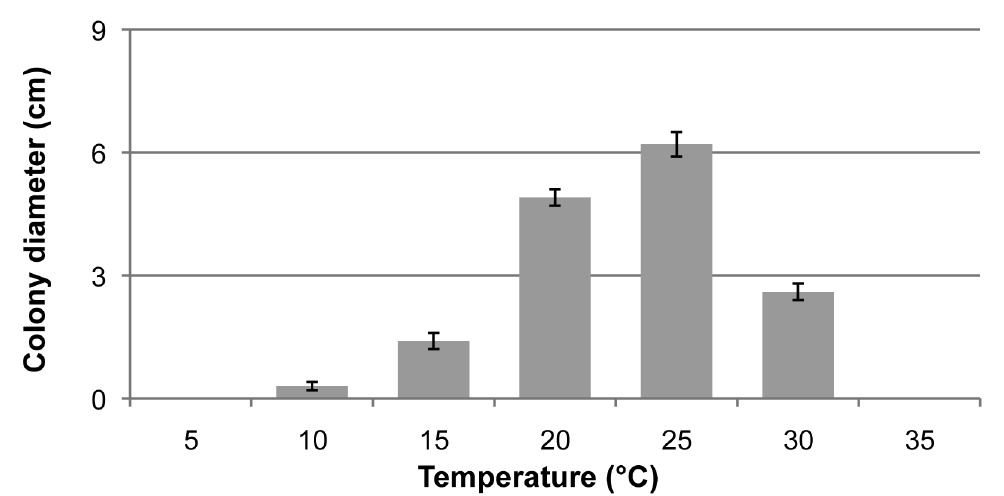
Figure 4. Mean colony diameters of Diplodia africana grown on PDA at different temperatures. Bar represents standard